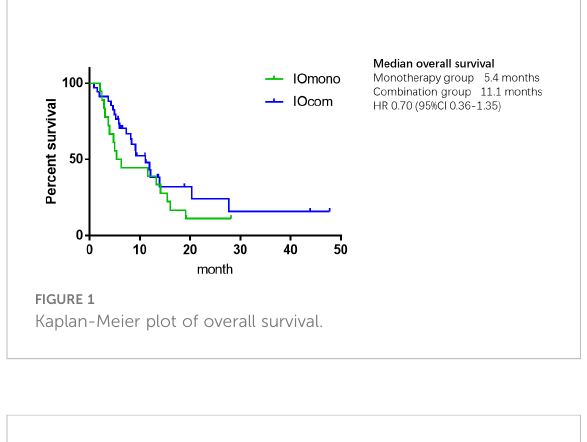
FIGURE 1 Kaplan-Meier plot of overall survival.